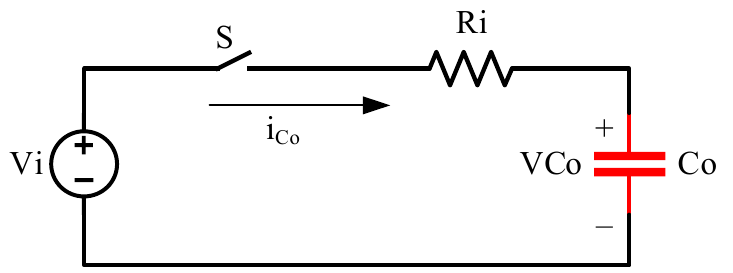
Figure 18. RC circuit used in the analysis of the charge and discharge of capacitors in SC converters. In this case, the equivalent model of the converter is considered as a first-order R i C o circuit with time constant τ , where R i = R sw + ESR, R sw being the resistance of the switch, while C o represents the capacitor in the charge or discharge regime. The switch is turned on to charge the capacitors during a time interval T on over a switching period T s . Thus, it is reasonable to state that SC circuits are often designed based on the time constant rather than the switching frequency. Besides, such converters are capable of operating in full charge condition even at high frequencies according to the specifications of capacitors and switches used in the